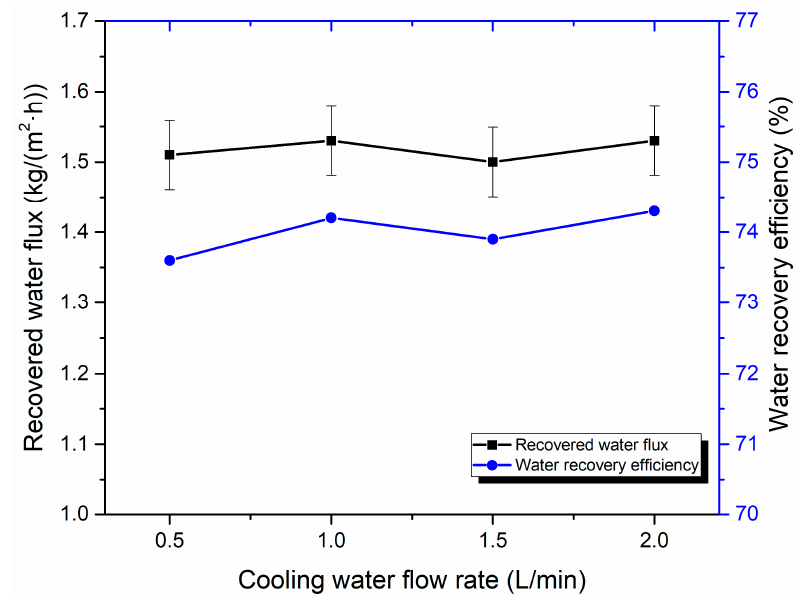
Figure 14. Effect of cooling water flow on water recovery performance (Experiment conditions: flue Figure 14. E ff ect of cooling water flow on water recovery performance (Experiment conditions: